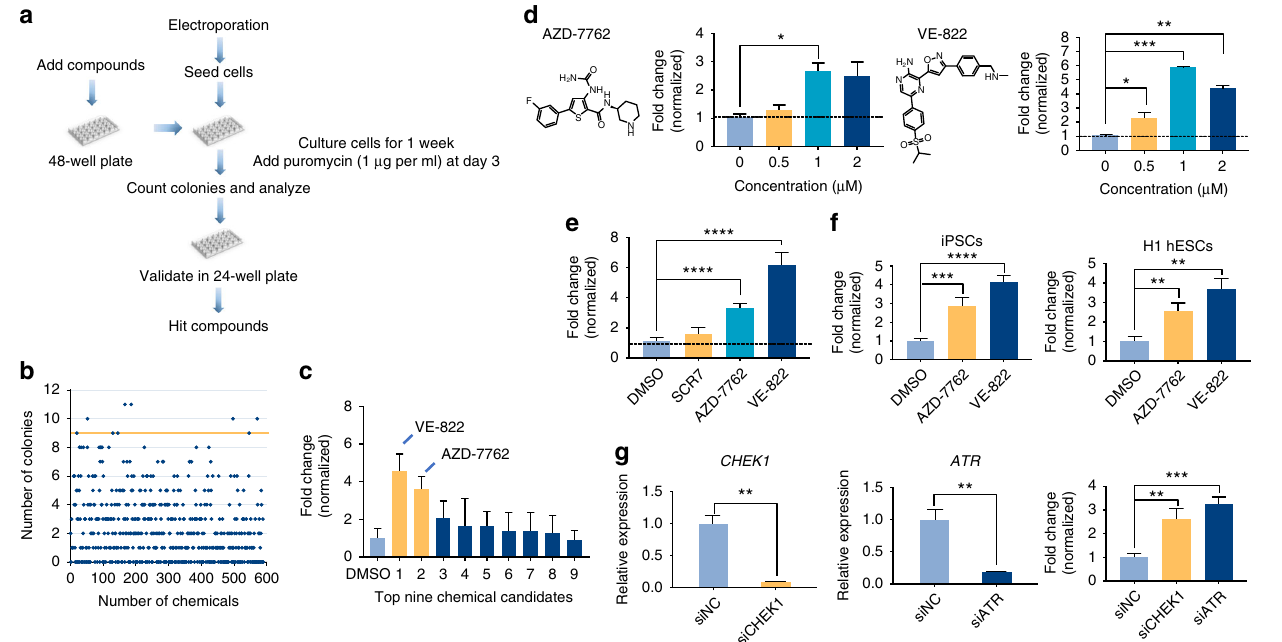
Fig. 2 Identi fi cation of small molecules that can signi fi cantly promote CRISPR-Cpf1-mediated knockin in hPSCs. a A scheme of chemical screening. b The result of chemical screening. About 600 small molecules were screened, and the puromycin-resistant colony number was counted. Small molecules above the orange line were top chemical candidates for further con fi rmation. The average colony number of DMSO was 2. c The con fi rmation result of top small molecule candidates. VE-822 and AZD-7762 were the top two small molecules that increased the number of puromycin-resistant colonies. d The concentration tests of VE-822 and AZD-7762. n = 3 experiments. Statistical signi fi cance calculated using two-tailed Student ’ s t -test, compared to DMSO controls. * P < 0.05, ** P < 0.01, *** P < 0.001. e The effects of VE-822 (1 μ M), AZD-7762 (1 μ M), and SCR7 (1 μ M) in context of CRISPR-Cpf1-mediated knockin in hPSCs. n = 5 experiments. Statistical signi fi cance calculated using two-tailed Student ’ s t -test, compared to DMSO controls. **** P < 0.0001. f The effects of VE-822 and AZD-7762 were replicated in H1 hESCs and hiPSC lines. n = 4 experiments. Statistical signi fi cance calculated using two-tailed Student ’ s t -test, compared to DMSO controls. ** P < 0.01, *** P < 0.001, **** P < 0.0001. g Knockdown of ATR and CHEK1 by siRNAs and their effects on CRISPR-Cpf1-mediated knockin in hPSCs. n = 3 experiments. Statistical signi fi cance calculated using two-tailed Student ’ s t -test, compared to siNC controls. ** P < 0.01, *** P <